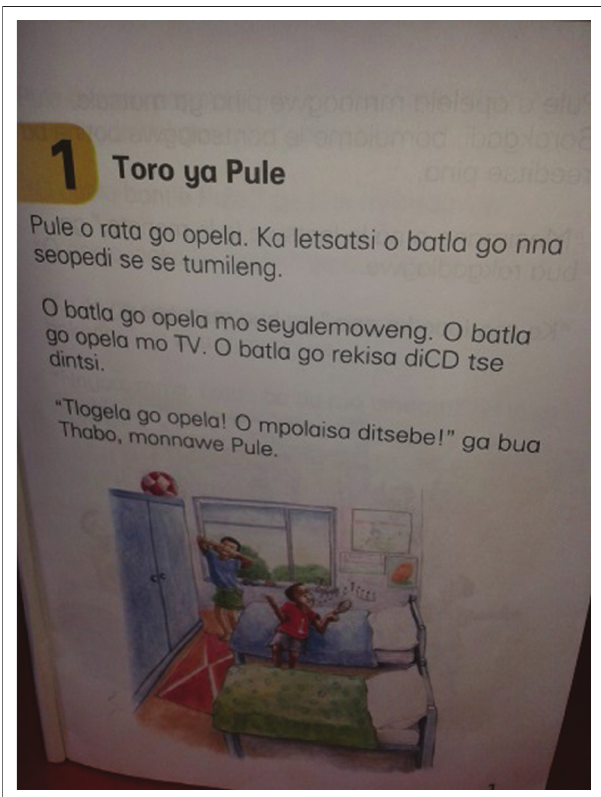
FIGURE 4: Go thuba lebelo (Mekgwe 2012) – School